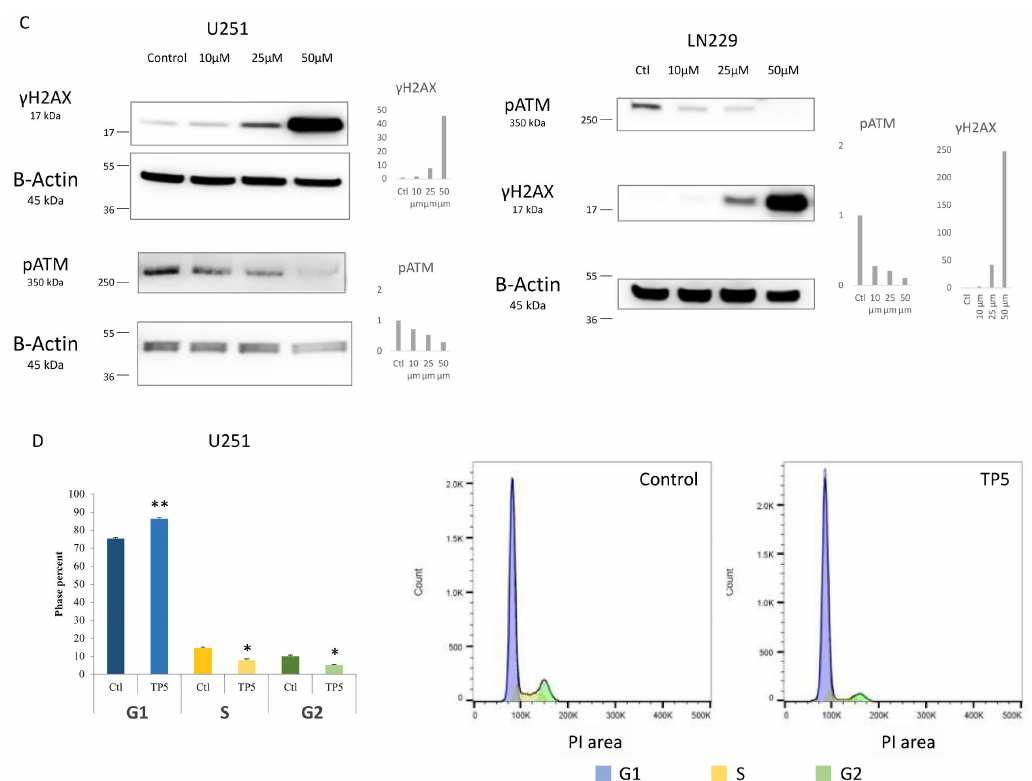
Figure 3 . TP5 affects cell cycle by impairing DNA damage repair. ( A ) Immunofluorescent staining of γH2A.X (green) in U251 and LN229 cells after treatment of TP5 at indicated concentrations. ( B ) The bar graph displays the quantification of γH2A.X foci per U251 and LN229 cell treated at indicated concentrations (ten random fields of view for each group, on 3 distinct experiments; * p < 0.05, *** p < 0.001). ( C ) Western blot of phosphorylated ATM and γH2A.X in U251 cells (left panels) and LN229 cells (right panels) treated by TP5 at indicated concentrations. ( D ) Cell cycle analysis in U251 cells treated by TP5 at 25 µM for 48 h. The graph bar displays the cell cycle phase quantification ( N = 3; * p < 0.05; ** p < 0.01).